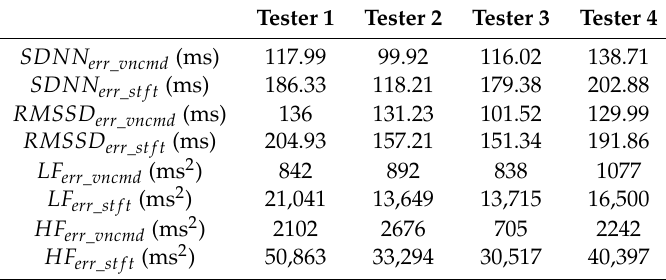
Table 2. Heart rate variability analysis on resting testers in Spot